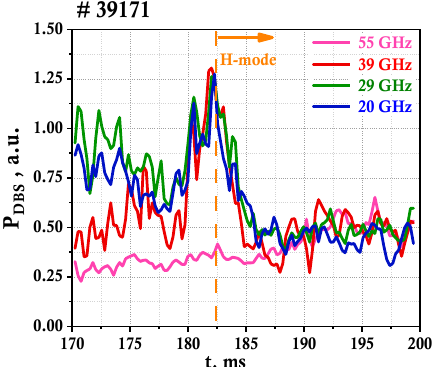
Figure 8. Temporal evolution of DBS power for discharge #39171.